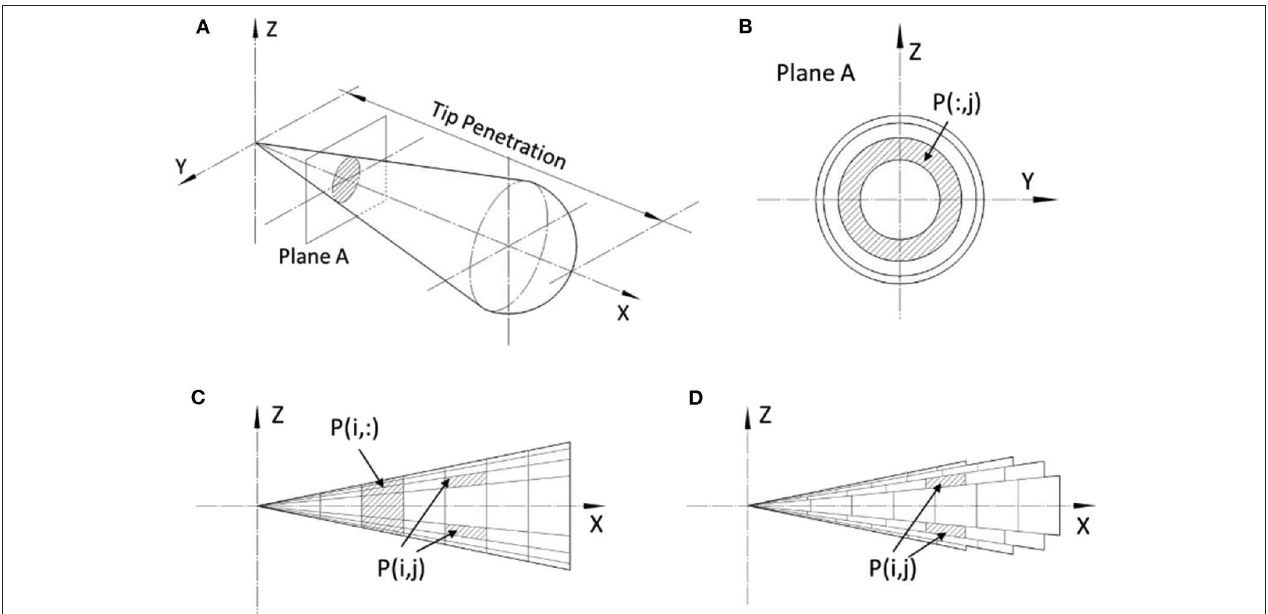
FIGURE 1 | (A-D) Spatial illustration of diesel spray combustion modeling